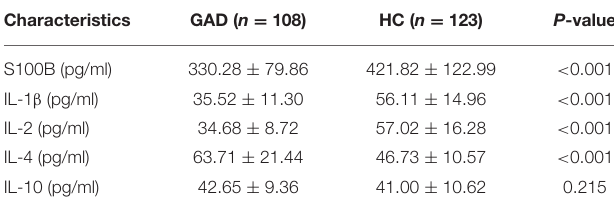
TABLE 2 | Clinical characteristics of GAD and HC.